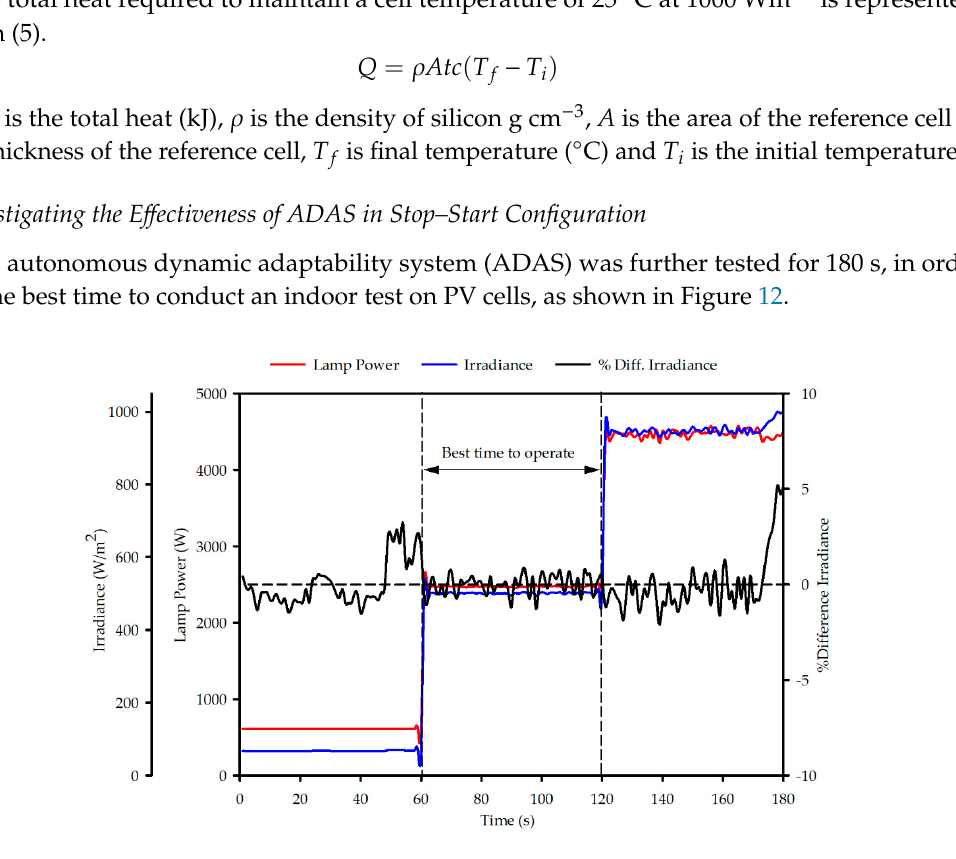
Figure 12. Reference cell response to irradiance from the solar simulator.